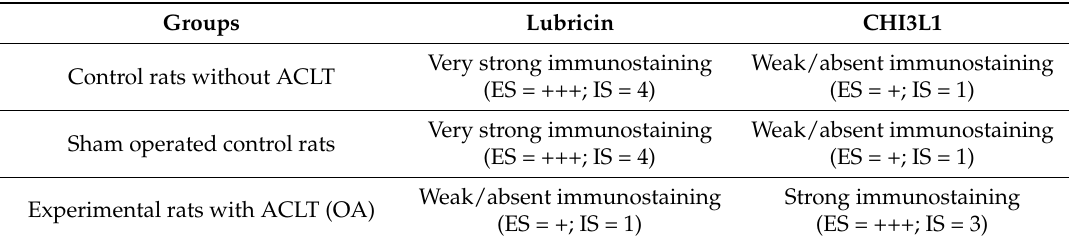
Table 1. Evaluation of lubricin and chitinase 3-like-1 (CHI3L1) immunostaining. Intensity immunostaining (IS); Percentage of immunopositive cells expressed by Extent Score (ES): <5% (0);